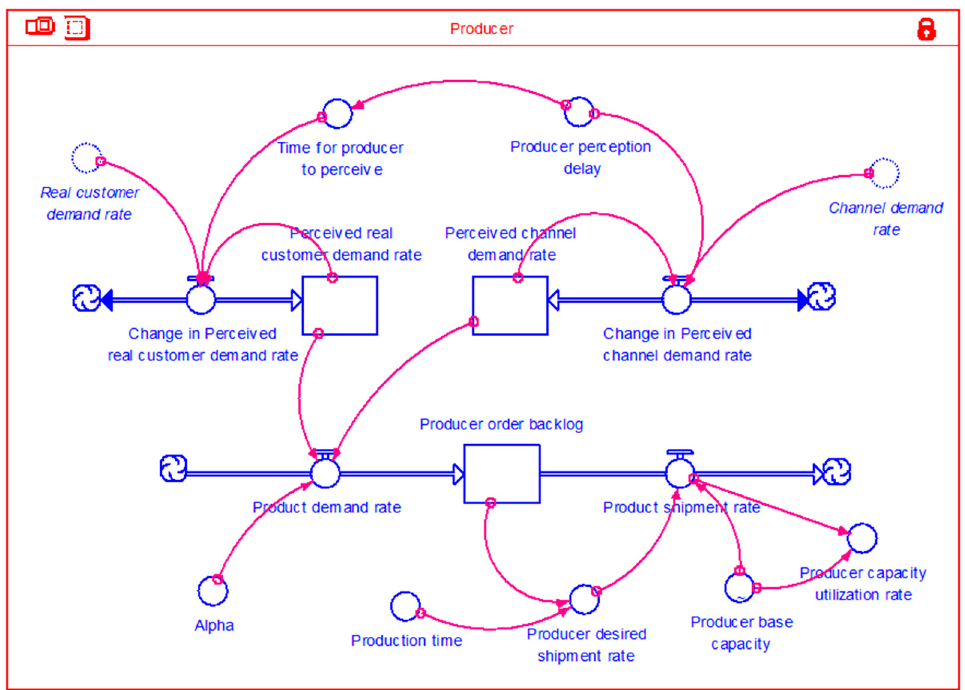
Figure 1. Producer’s production simulation model for Scenario 1.